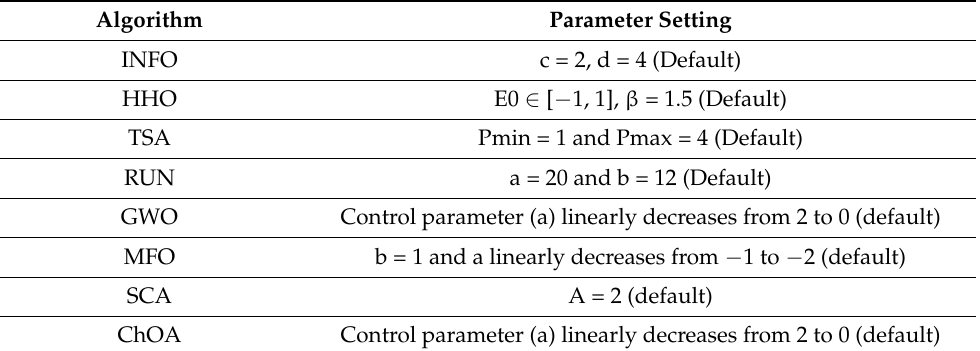
Table 2. The algorithm parameter setting.